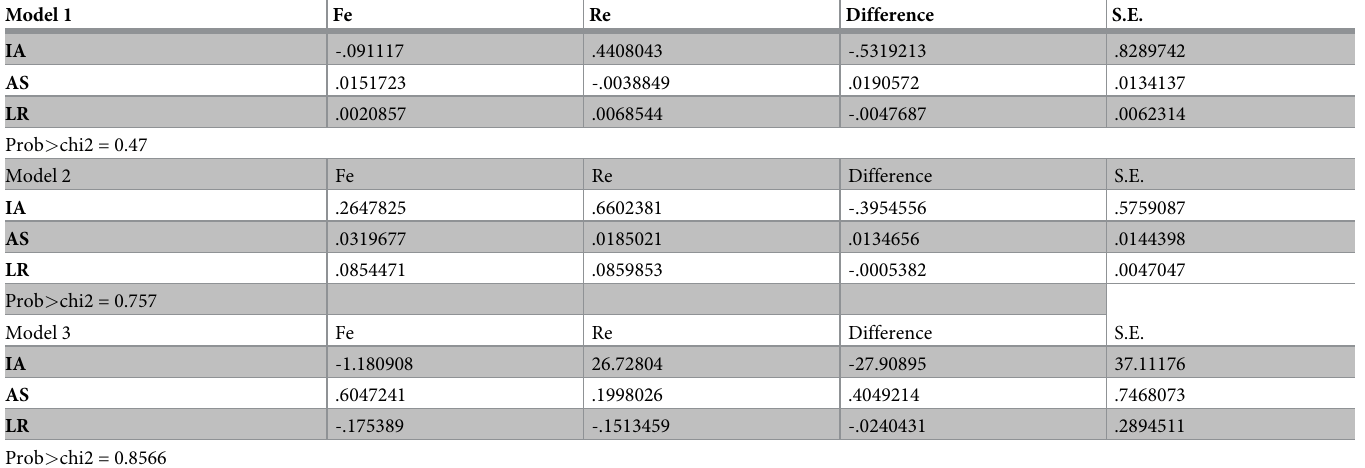
Table 4. Random and fixed effect